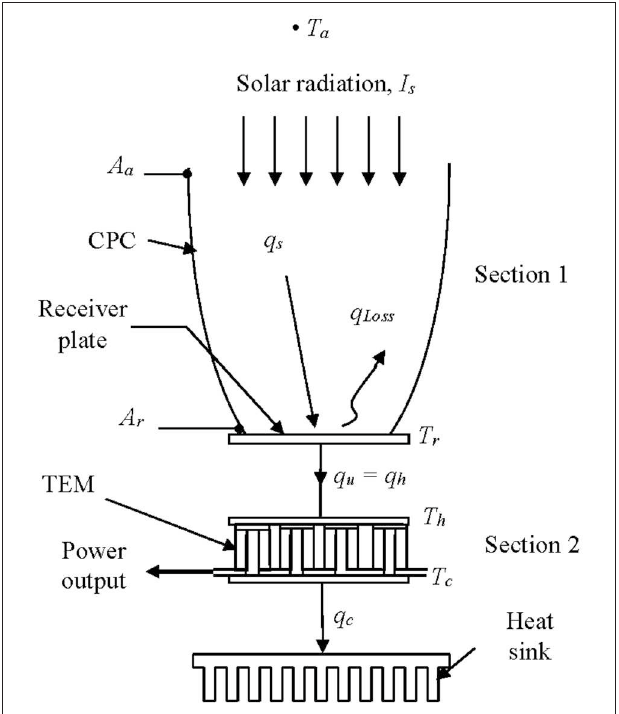
FIGURE 1 | A schematic diagram of the hybrid system.